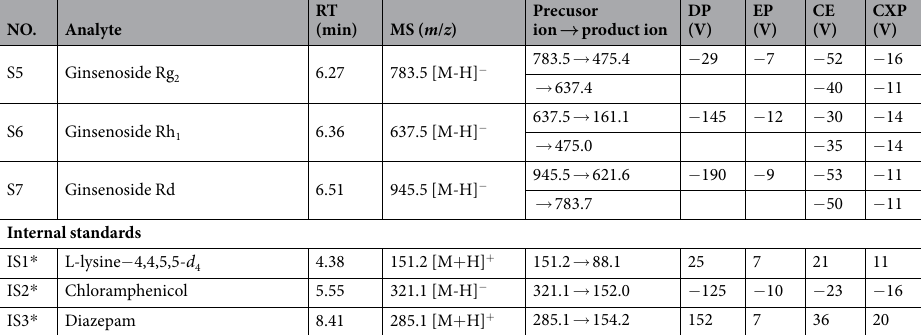
Table 1. Retention times and optimized mass spectrometry parameters of analytes and internal standards. * Internal standard, a quantitative ion pair, b qualitative ion pair. RT, retention time; DP, declustering potential; EP, entrance potential; CE, collision energy; CXP, cell exit